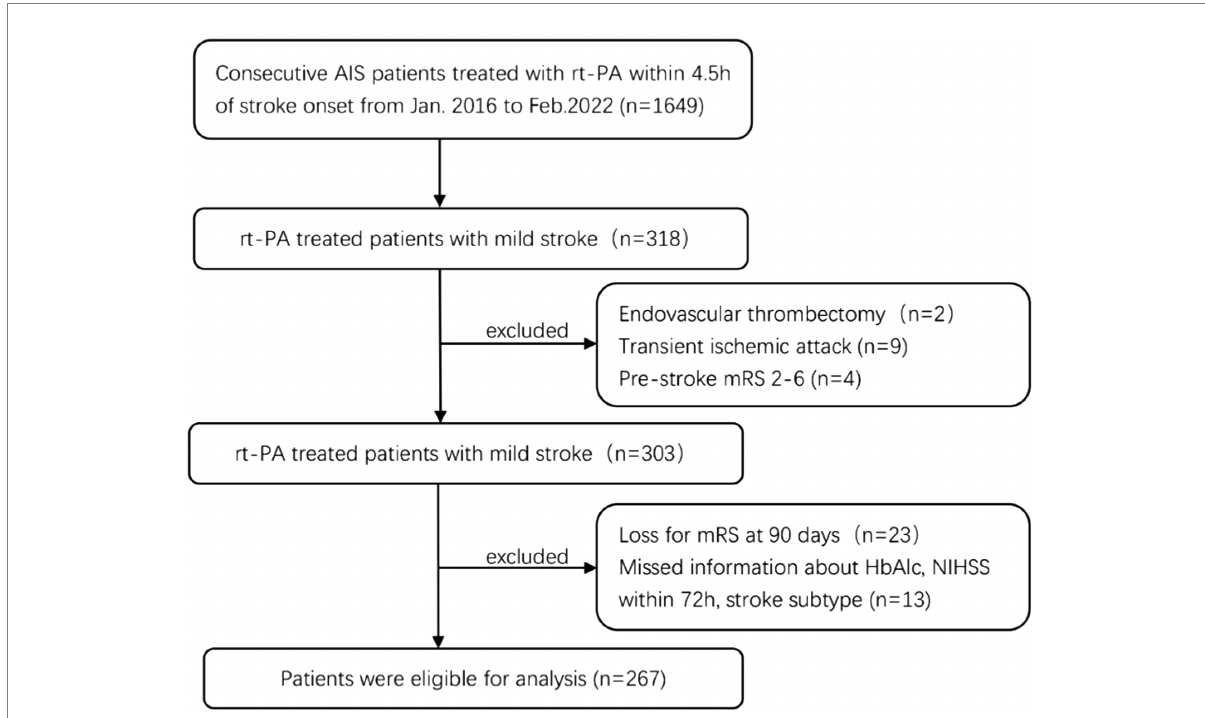
FIGURE 1 Study inclusion flow chart. AIS, acute ischemic stroke; rt-PA, recombinant tissue plasminogen activator; mRS, modified Rankin Scale Score; HbA1c, glycated hemoglobin; NIHSS, National Institute of Health Stroke